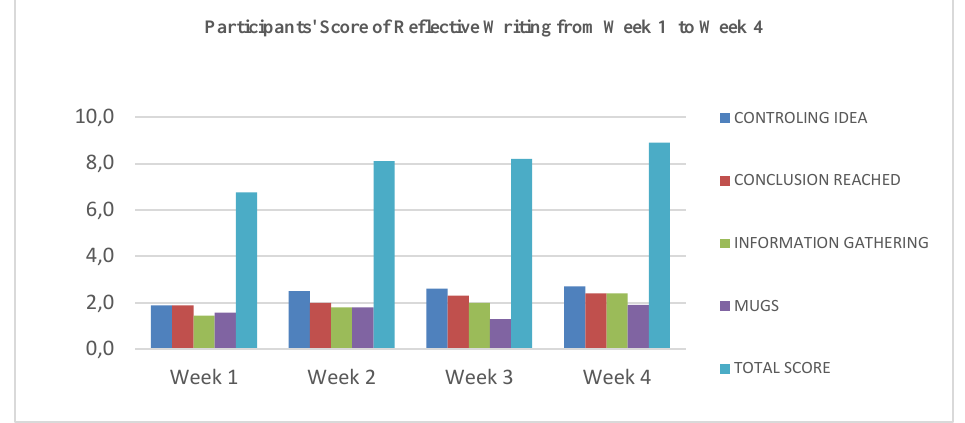
Chart 5: Average score of reflective writing from Week 1 to week